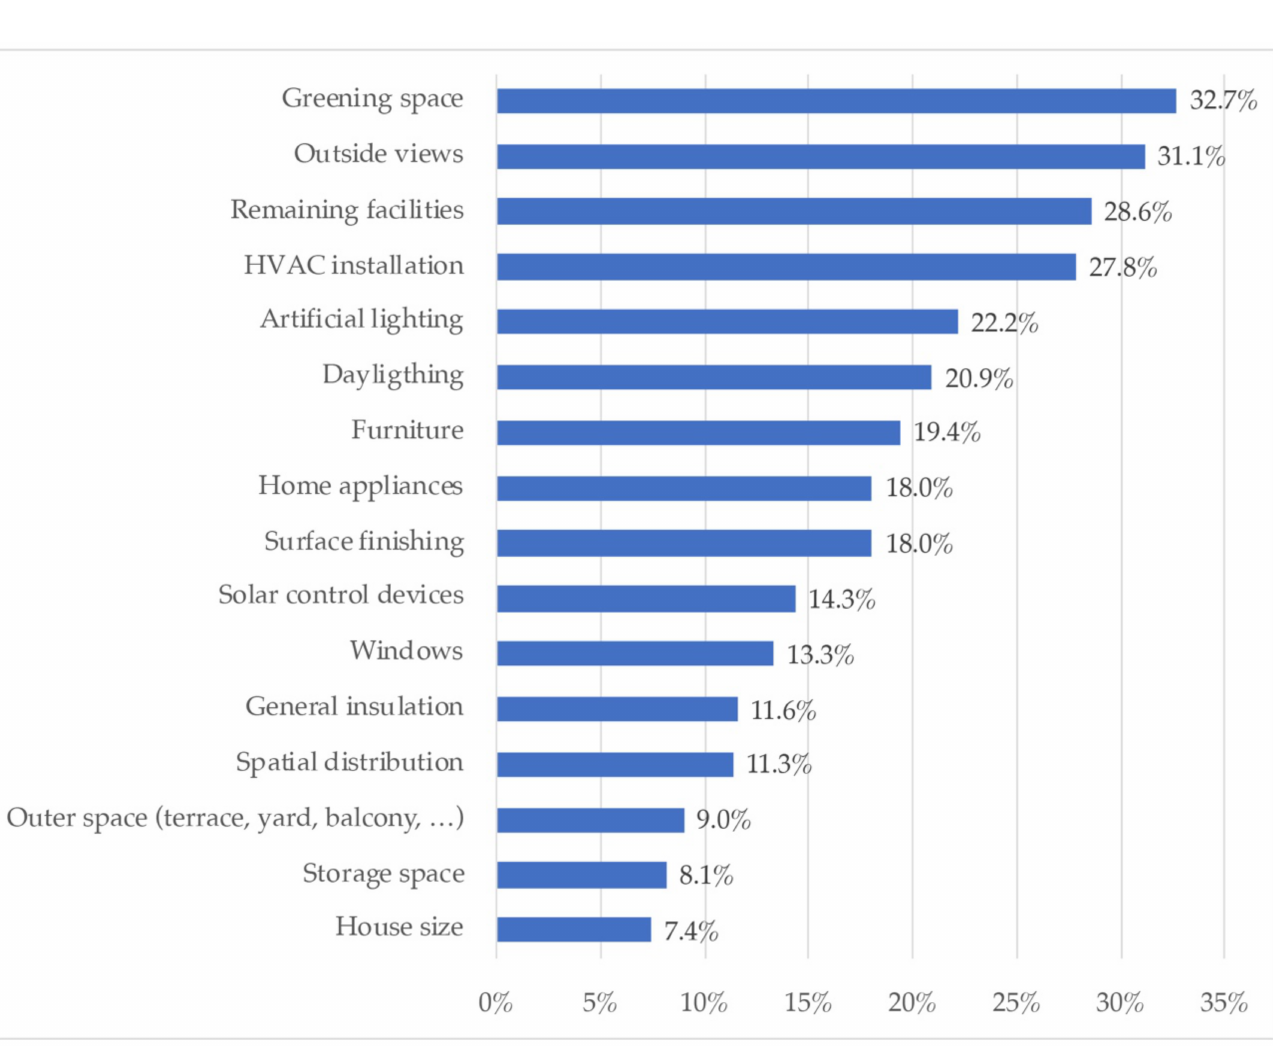
Figure 14. Aspects about the housing that the inhabitants would change, if